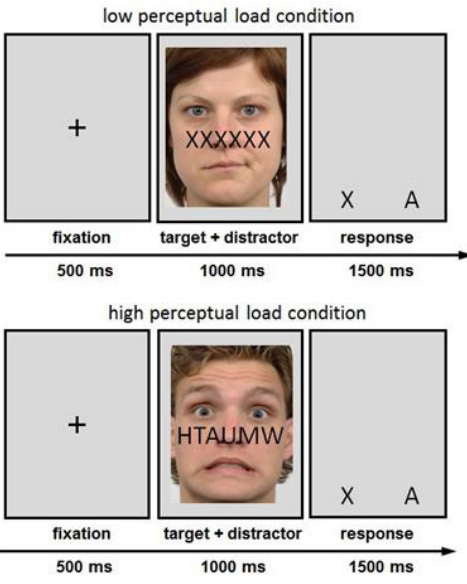
Figure 1. FMRI Figure 1. FMRI paradigm.